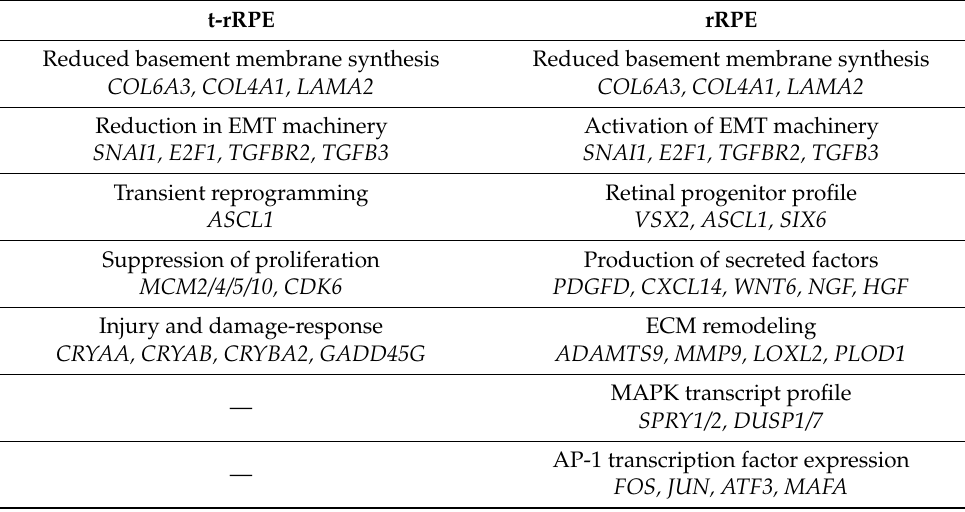
Figure 6. Schematic representation of the changes in gene expression. Major findings from the study are summarized in the diagram and table below, including the key biological processes associated with changes in gene expression in t-rRPE and rRPE. Example genes are listed for each category. Table 1. Associated functions in the t-rRPE and rRPE.